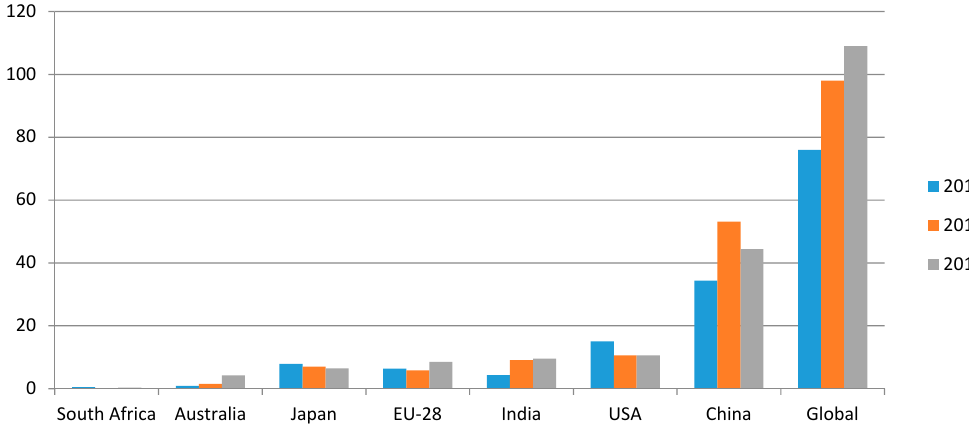
Figure 2. c-Si cell and module price (Euro/Wp, USD/Wp) evolution on the European and American markets [28-32].